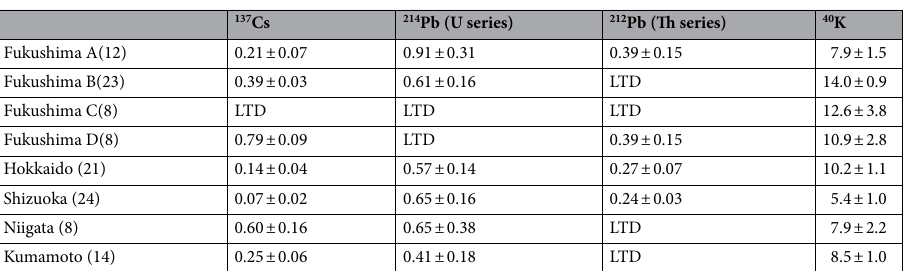
Table 3. Radioactivity of 137 Cs and natural radionuclides in deciduous teeth (mBq/g). Data are shown as mean ± counting error. Parentheses show numbers of teeth in a sample. When the counts did not exceed the mean + 3SD of the background, we considered the value as LTD (lower than detection limit). SD, standard deviation. Since radioactive caesium was not detected during the 1 million seconds measurement (11.6 days), we increased the duration of measurement (Table 1) to 1.6–3.0 million seconds (18.5–34.7 days) to increase peak counts (662 keV). The teeth from the Fukushima prefecture were divided into the following 4 groups according to the time they fell out: Fukushima A, before the FNPP accident; Fukushima B, 0–2 after the FNPP accident; Fukushima C, 2–4 after the FNPP accident; and Fukushima D, 4–6 years after the FNPP accident. 134 Cs was undetectable in all samples.